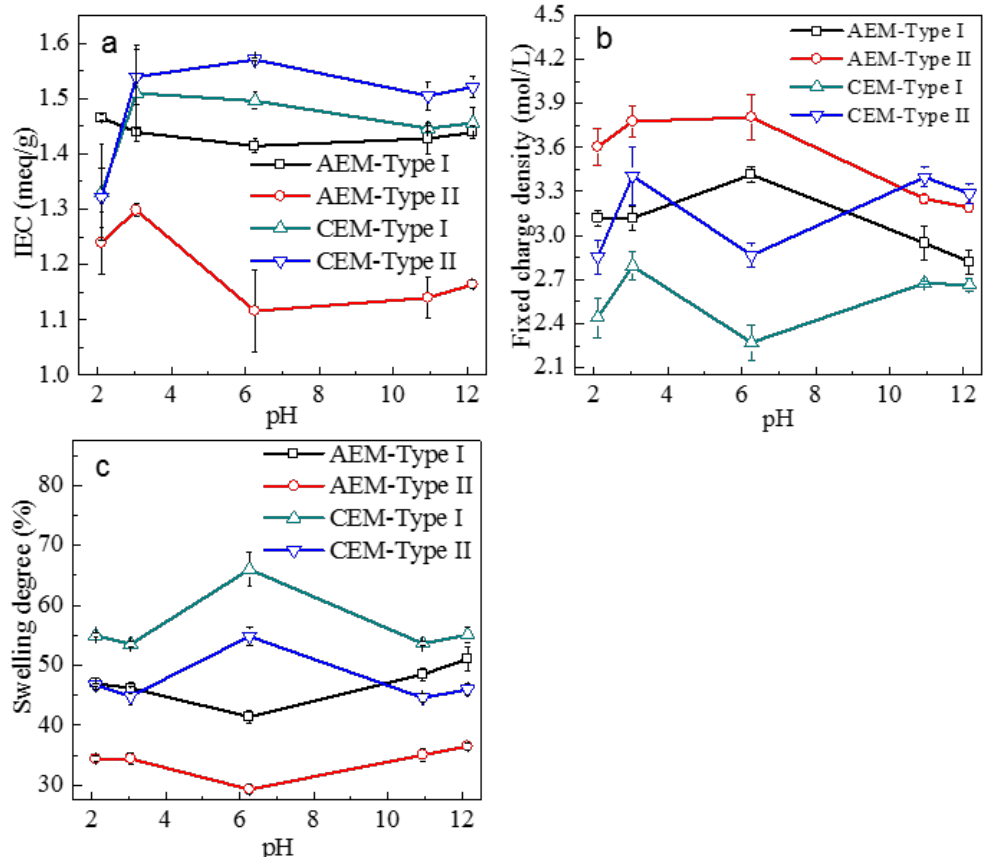
Figure 6. ( a ) Ion exchange capacity, ( b ) fixed charge density, and ( c ) swelling degree of four ion-exchange membranes as a function of pH. NaOH or HCl was used to adjust the pH of the solutions.